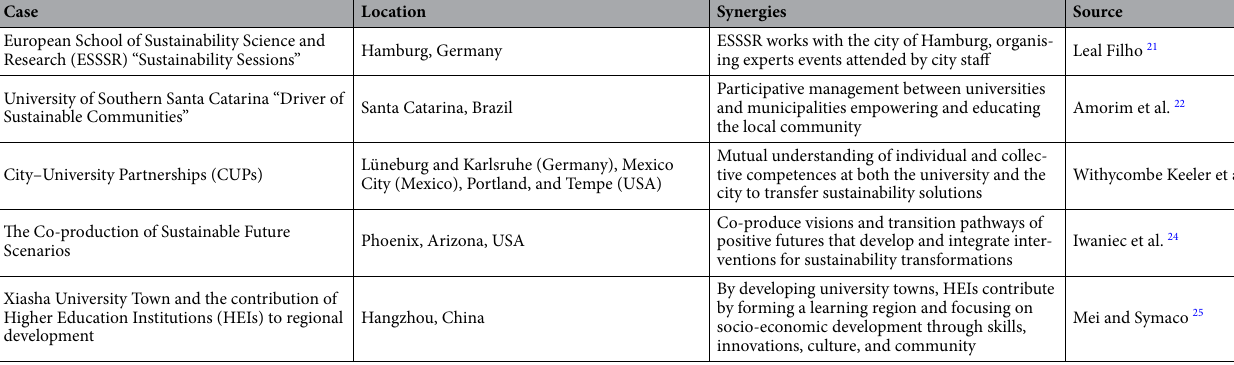
Table 1. Some examples of synergies between universities and cities in the context of sustainable development.